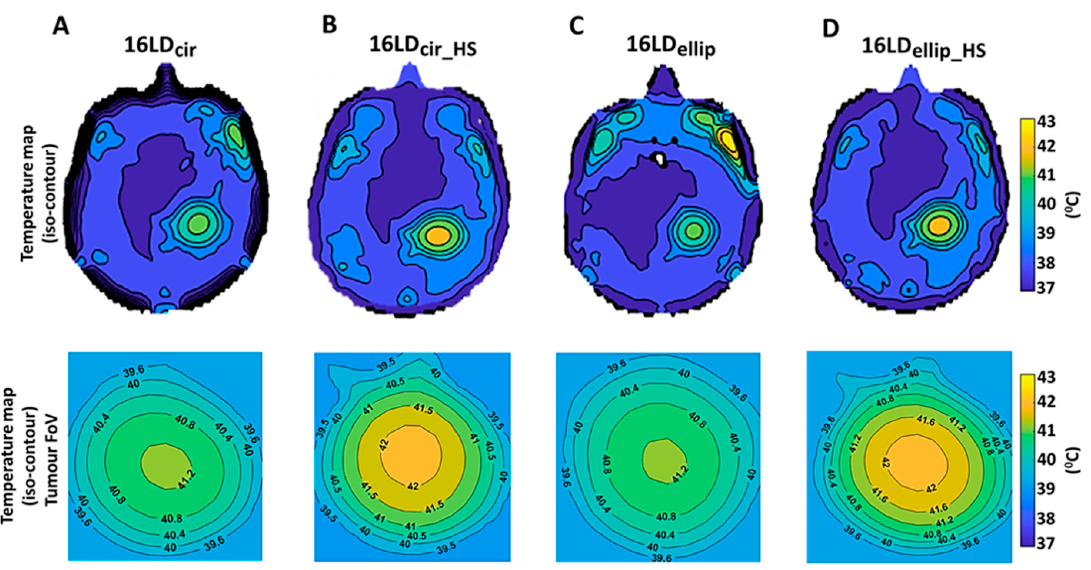
Figure 12. Iso-contour temperature distributions maps of Duke’s head (central axial slice) based on SAR 10g deposition from targeted RF heating. Top row of iso-contour temperature maps of 16LD ThermalMR RF applicators ( A ) 16LD cir , ( B ) 16LD cir_HS , ( C ) 16LD ellip , ( D ) 16LD ellip_HS , showing the temperature increase from 37.4 ◦ C basal body temperature. The 16LD cir ( A ) and 16LD ellip ( C ) ThermalMR RF applicators show unwanted hotspots of ~42 ◦ C and ~43 ◦ C in the right facial muscles. Correspondingly, magnified field of view (FoV) (bottom row) of highlighted tumor region showing the detail temperature coverage results of T 40 ◦ C , T 41 ◦ C , T 42 ◦ C . Magnified FoV of the tumor region shows that the horse-shoe ThermalMR RF applicators yielded a higher temperature increase ( B ) 16LD cir_HS : ∆ T = 4.9 ◦ C, ( D ) 16LD ellip_HS : ∆ T = 4.8 ◦ C from 37.4 ◦ C basal body temperature than the ( A ) 16LD cir and ( C ) 16LD ellip ThermalMR RF applicators, both of which failed to achieve any